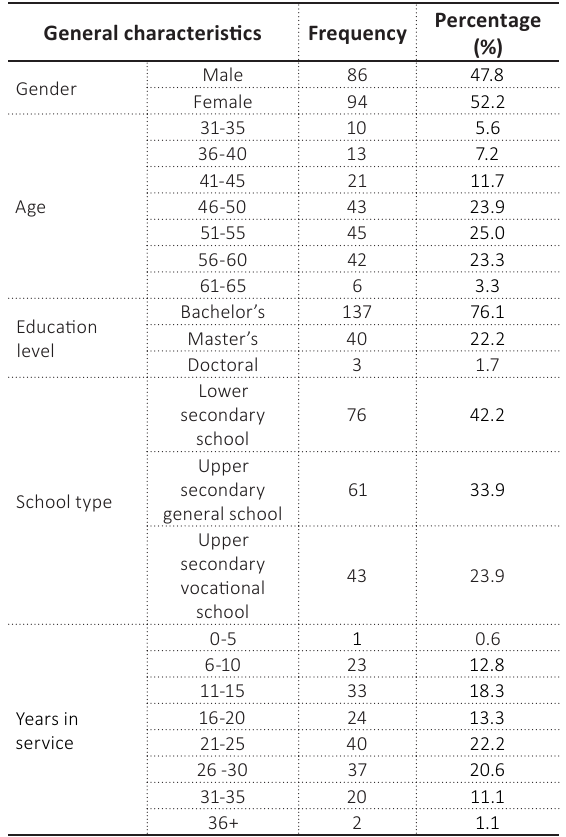
Table 1. Demographic characteristics of teachers